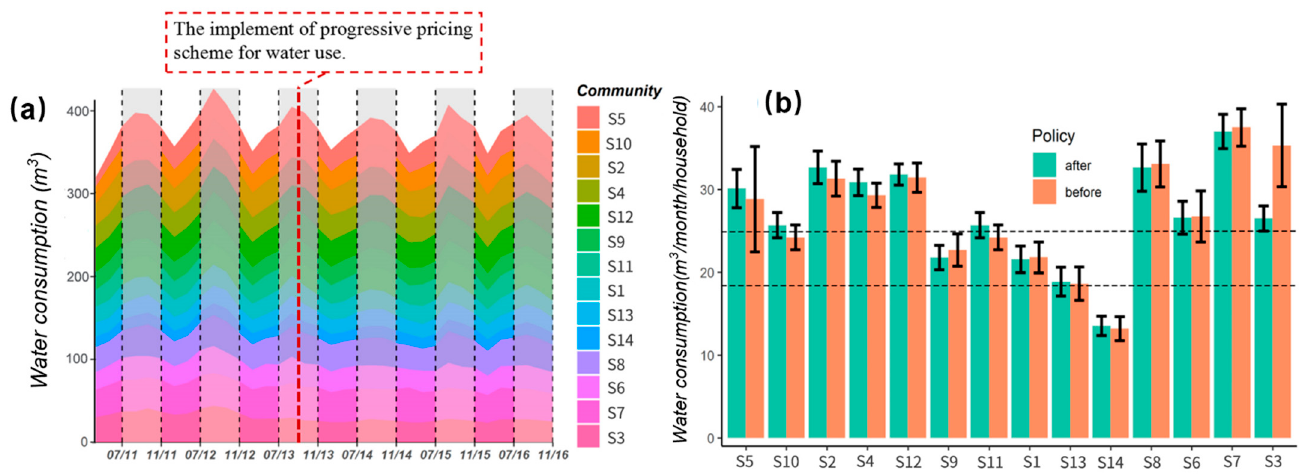
Figure 3. ( a ) Area plot (month/year) of the water use per household in the 14 communities. Grey areas refer to summer periods. Area’s height means the quantity of water use. ( b ) The household water consumption (m 3 ) before and after the implement of progressive pricing scheme for water use.